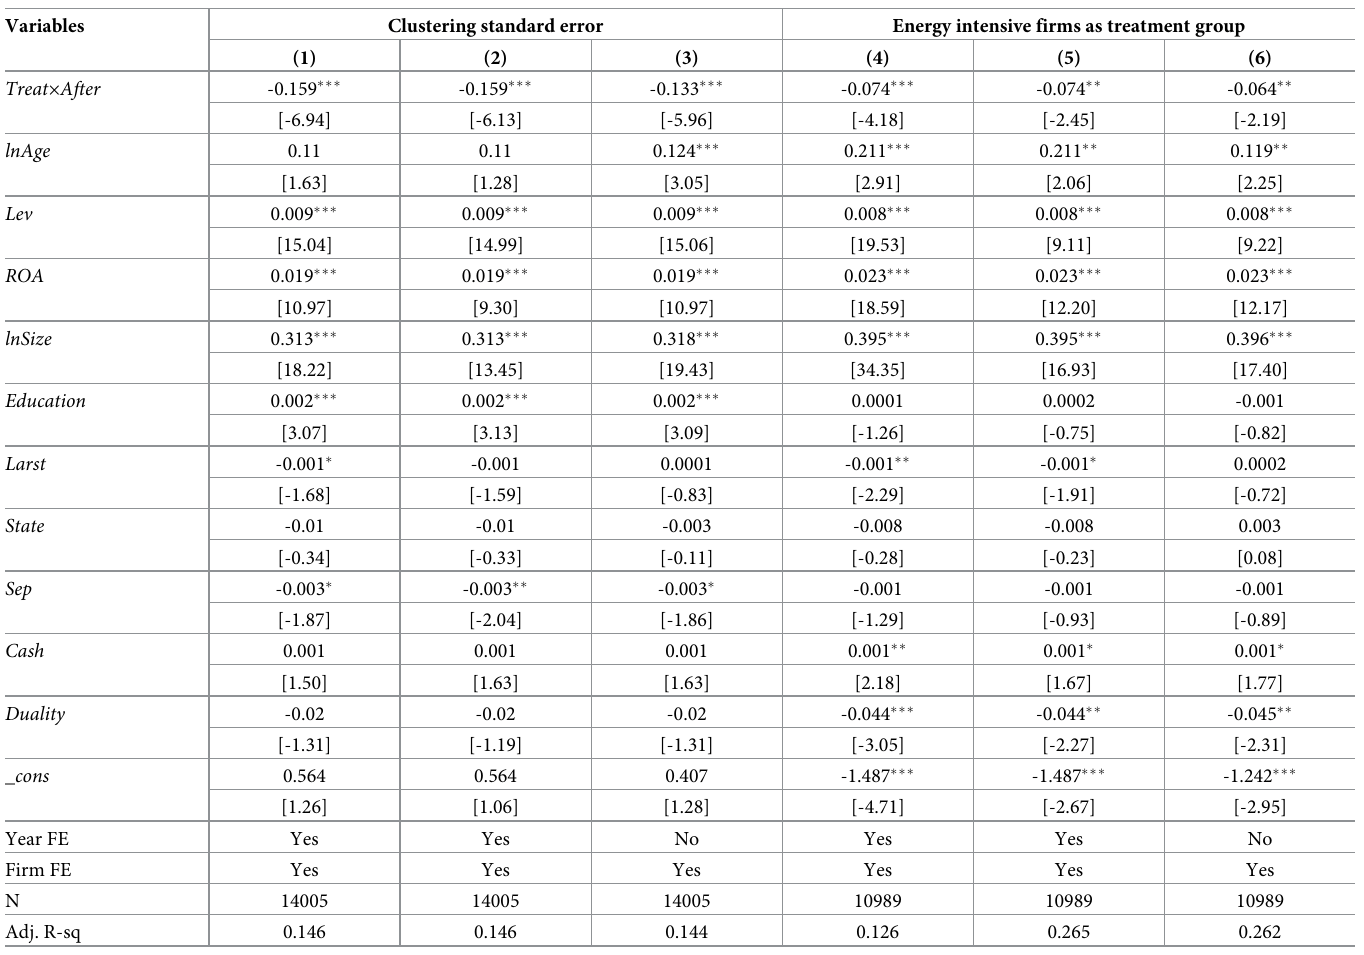
Table 8. Robust test of the policy intervention on the productivity of heavily polluting